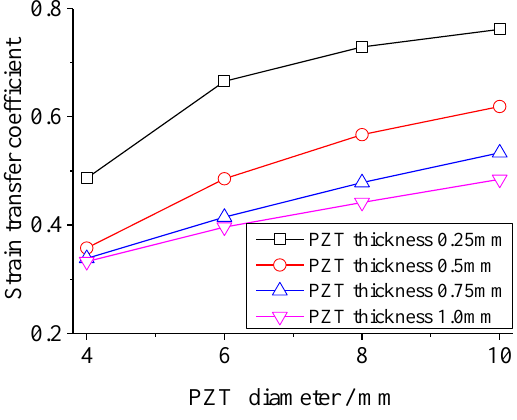
Figure 10. The strain transfer coefficient versus the PZT diameter in the FEA model.